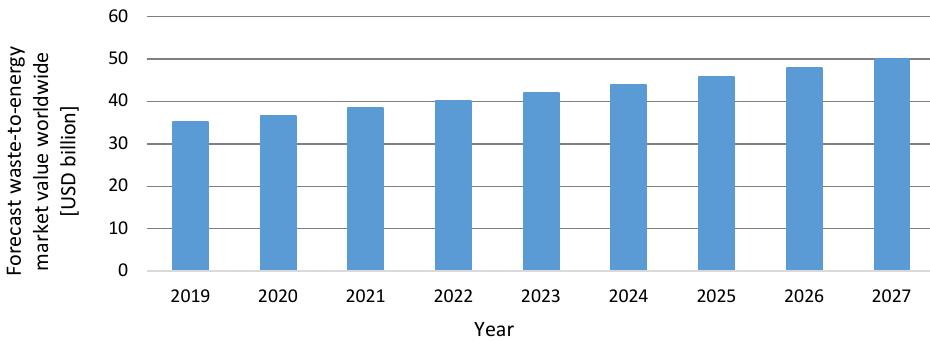
Figure 8. Global waste-to-energy market value forecast (2019–2027) [33].